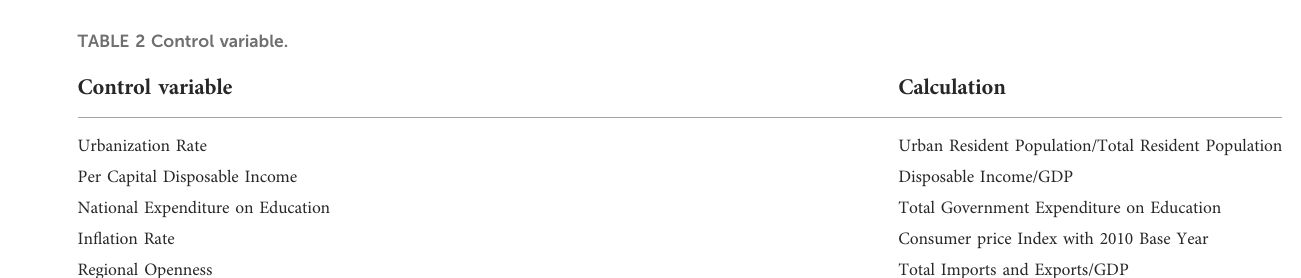
TABLE 2 Control variable.